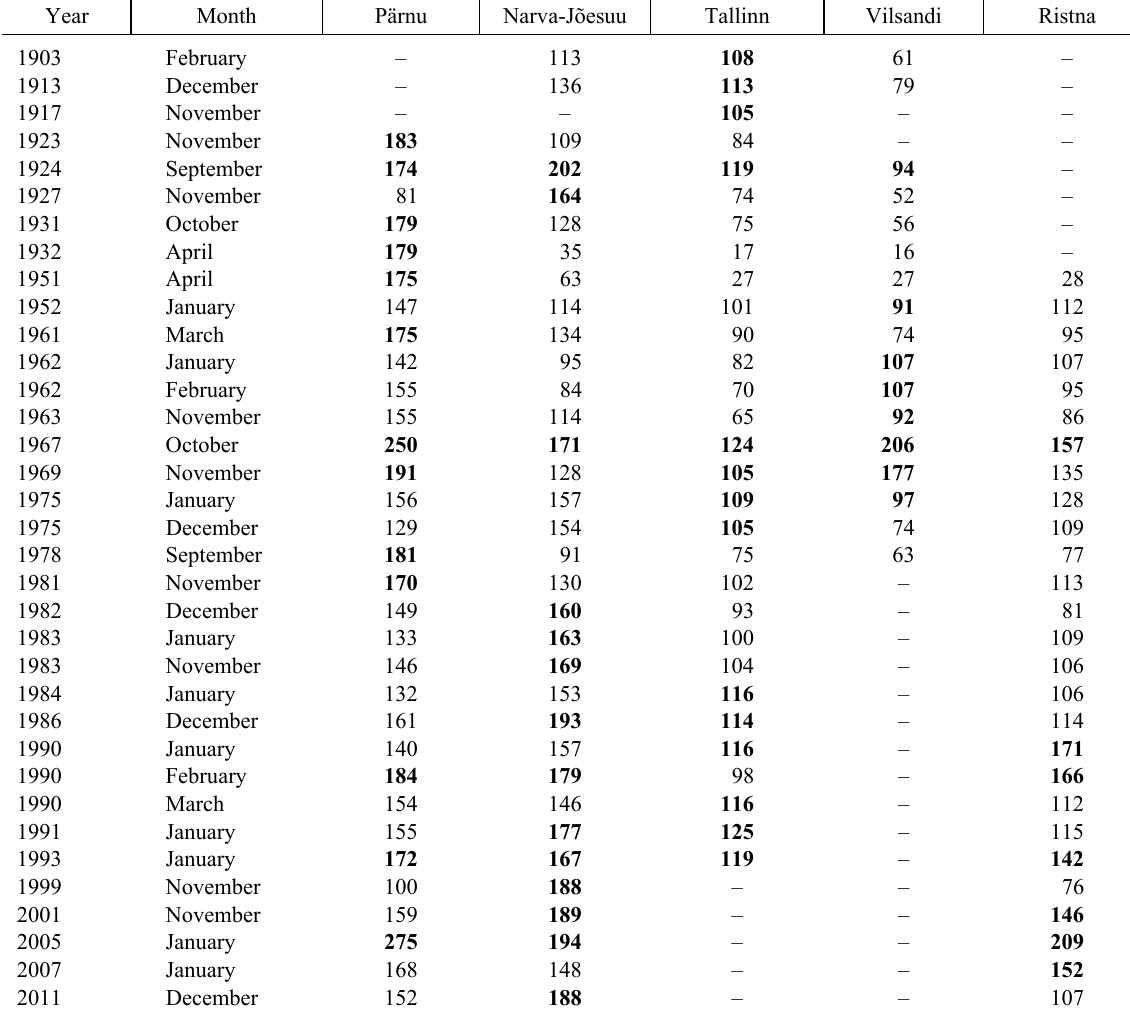
Table 2. Catalogue of extremely high sea level events in Estonia: the year and the month of the event and the corresponding maximum sea levels measured at five stations. The sea level heights exceeding the 90th percentile are typed in